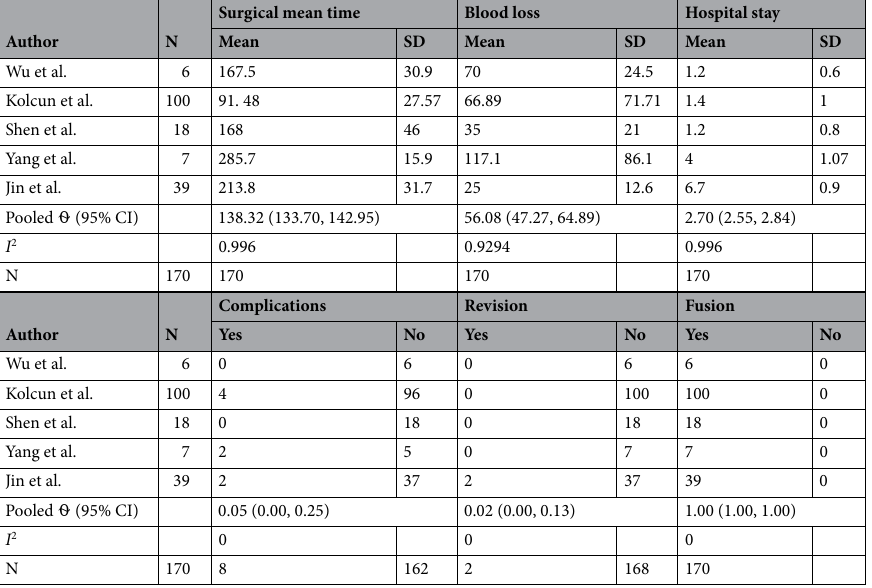
Table 2. Estimation of the pooled means and prevalences for surgical mean time, blood loss, hospital stay, complications, revision and fusion in iLIF